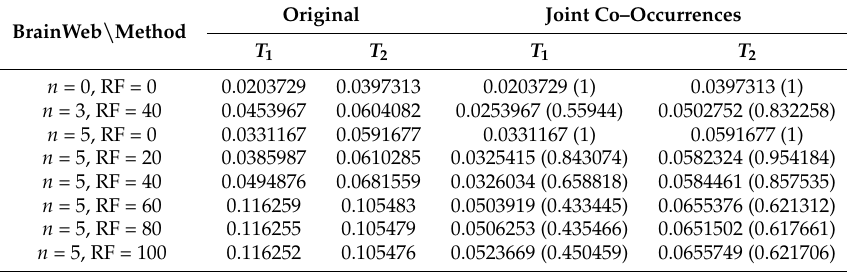
Table 2. Validation for BrainWeb phantom T 1 w and T 2 w images with difference to underlying anatomic images dif f t , i . A low value indicates improved performance. In parentheses is the ratio of after to before the restoration, dif f ratio . Low values and less than unity indicate improved performance. i BrainWeb \ Method